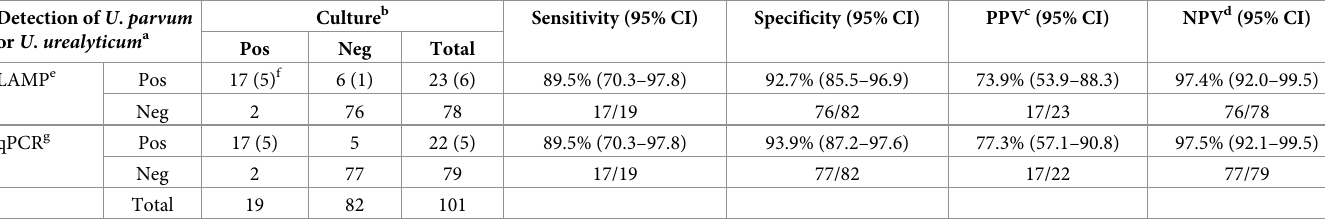
Table 3. Comparison of LAMP, quantitative real-time PCR, and culture results from 101 tracheal aspirate specimens. Detection of U . parvum or U . urealyticum